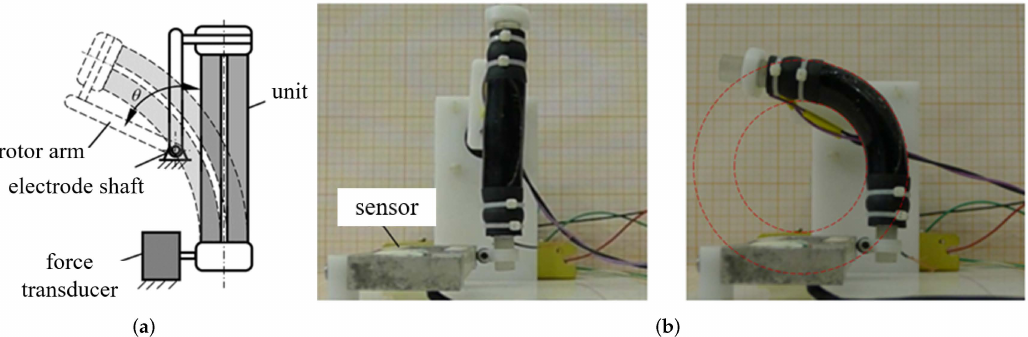
Figure 8. Bending device and test, where ( a ) is unit lateral force testing device and ( b ) is unit bending test.